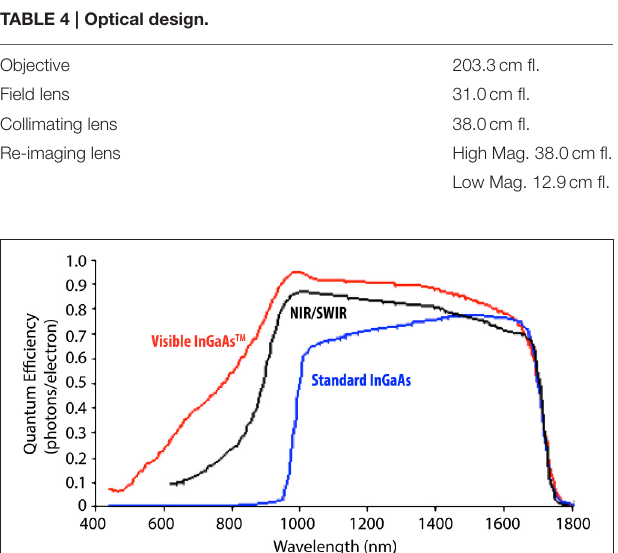
TABLE 4 | Optical design.